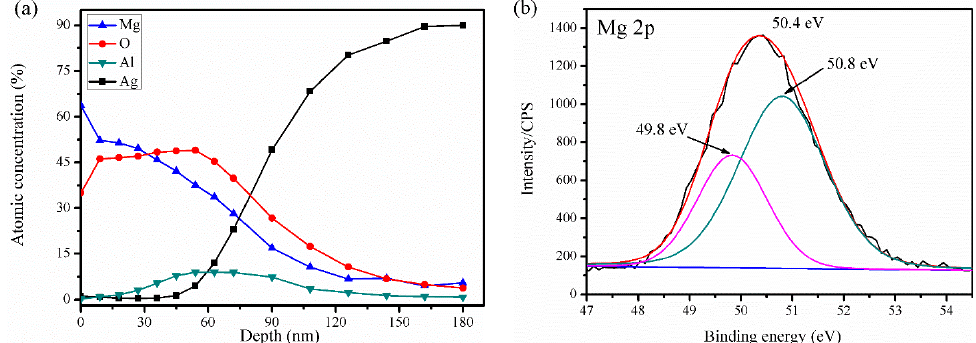
Figure 10. ( a ) Element depth profiles and ( b ) surface XPS spectra of the Ag-2Mg-2Al alloys activated at 500°C for 30 min at P O 2 = 20.0 Pa, after electron bombardment for 20 h.